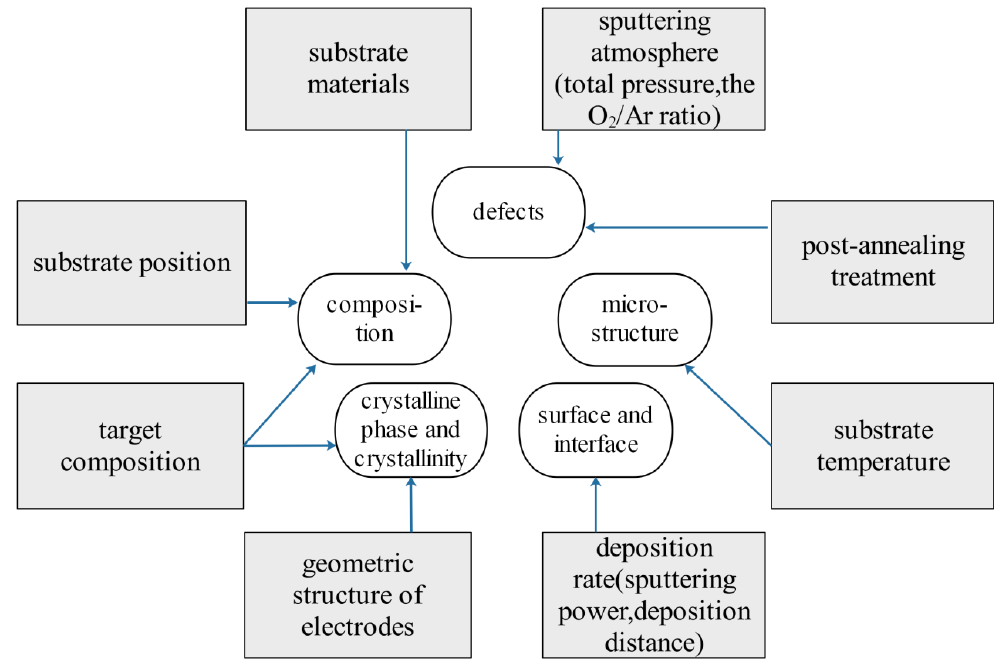
Figure 4. The relationship between sputtering parameters and film properties [60,61].